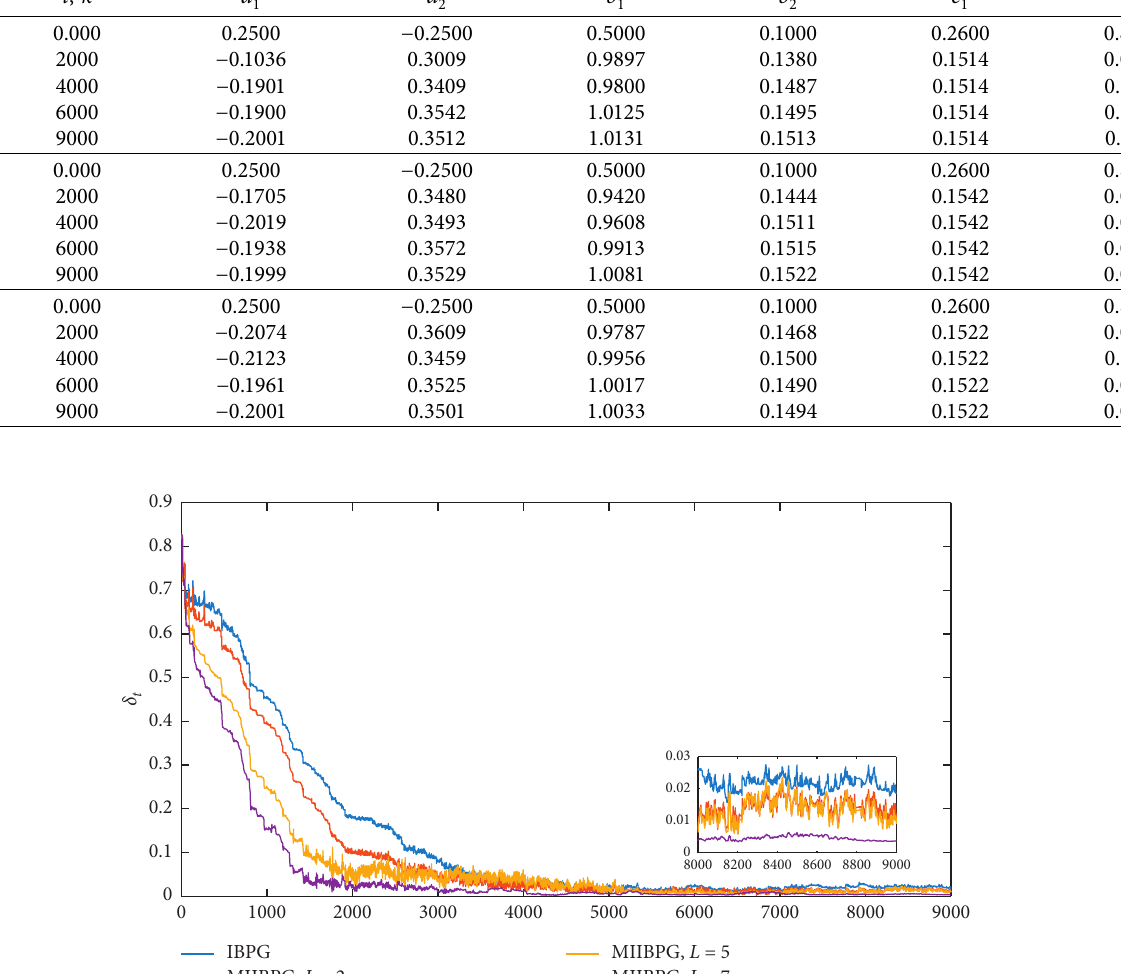
Table 4: The vector parameter estimates 􏽢 θ and 7.